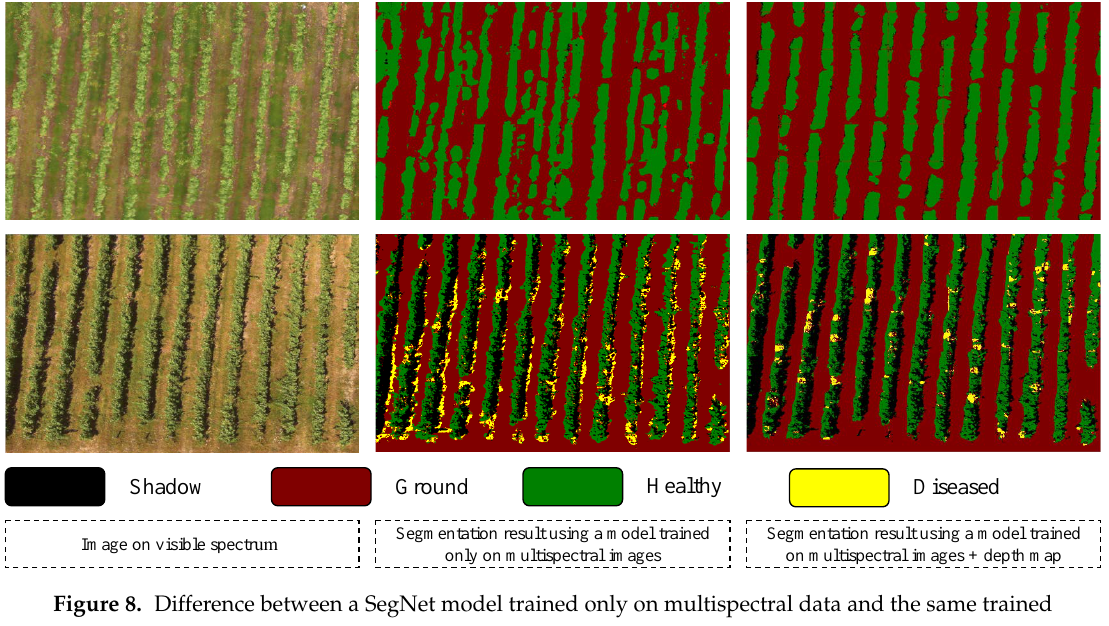
Figure 8. Difference between a SegNet model trained only on multispectral data and the same trained on multispectral data combined with depth map information. Two examples are presented here, the first row is an example on a healthy parcel with a green ground. The second one is an example on a partially diseased parcel with a brown